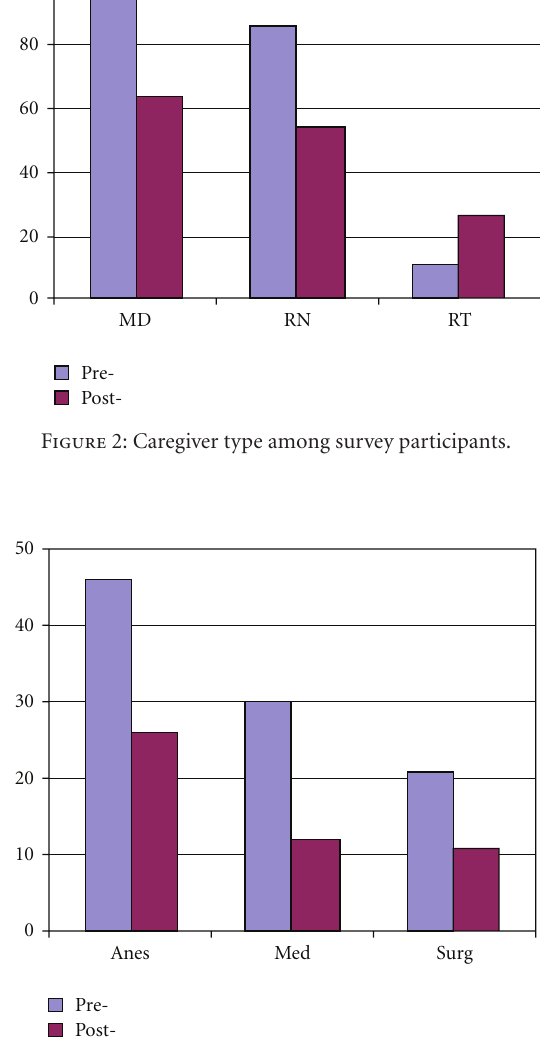
Figure 3: Physician specialty among survey participants.